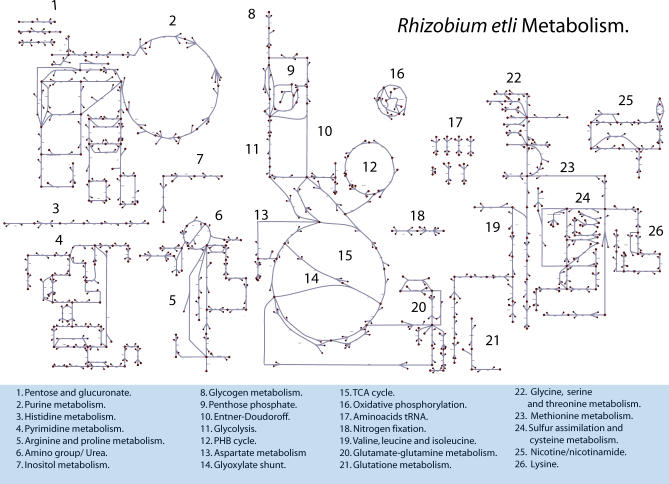
Metabolic Pathways for Rhizobium etli
The metabolic reconstruction for R. etli includes 26 metabolic pathways involving 363 genes and 383 metabolic reactions.